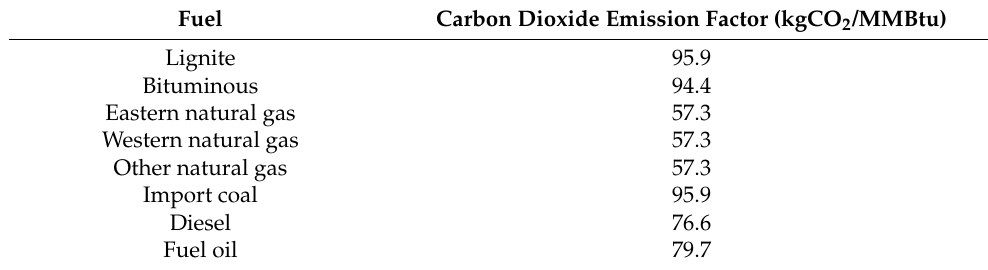
Table A11. Carbon dioxide emission